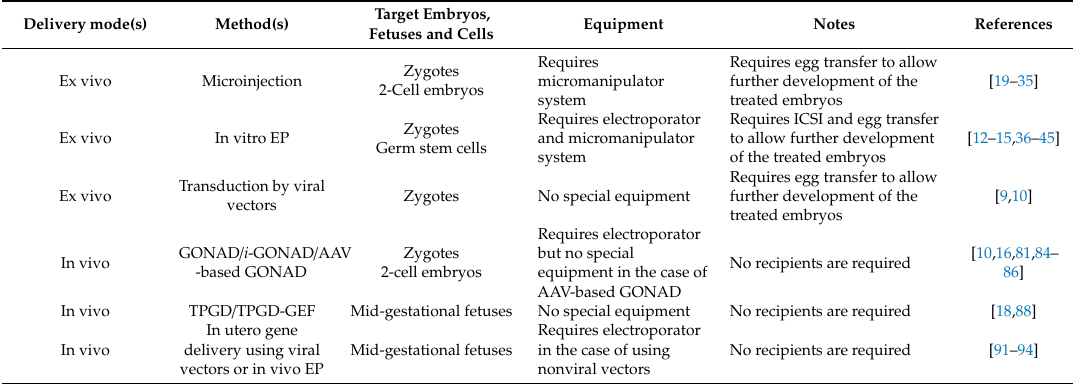
Table 1. Summary of the characteristic properties of the clustered regularly interspaced short palindromic repeats (CRISPR) / associated protein 9 (Cas9)-based genome-editing techniques used for embryos, fetuses, and germ cells in